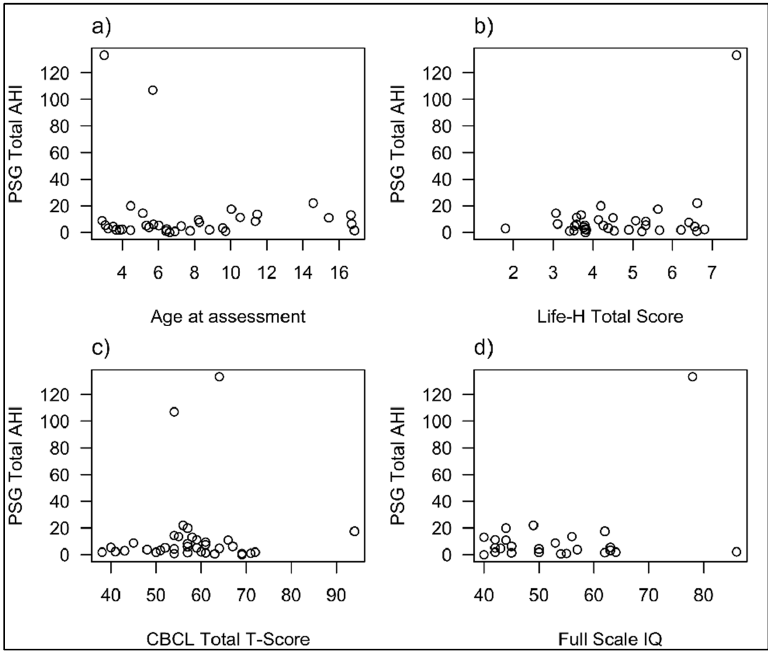
Figure 2. Relationship between sleep disordered breathing and age ( a ), functional ability ( b ), general behaviour ( c ) and IQ ( d ).